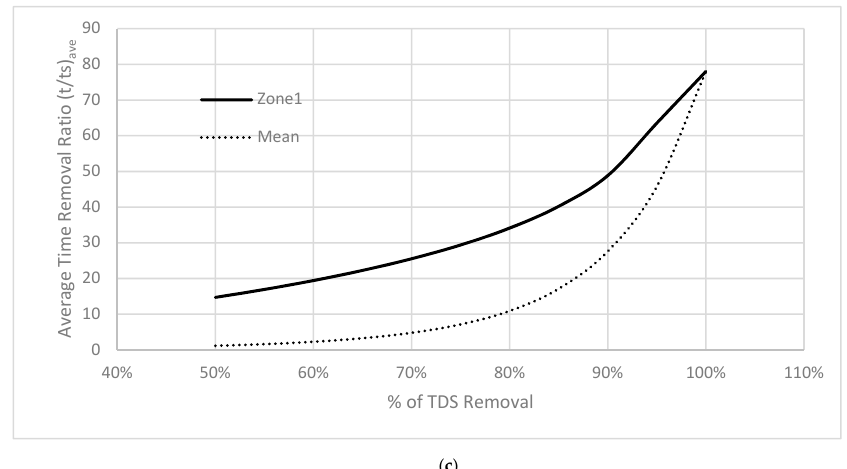
Figure 8. ( a ) Effect of R e and Purging Flow Rate on Time of TDS Removal Ratio (Zone 1, Xp/D = 7); ( b ) effect of R e and Purging Flow Rate on Time of Removal Ratio (%TDS Removal = 95%, Xp/D = 7); and ( c ) average Time of Removal Ratio for Achieving a Specified % of TDS Removal (Xp/D = 7).